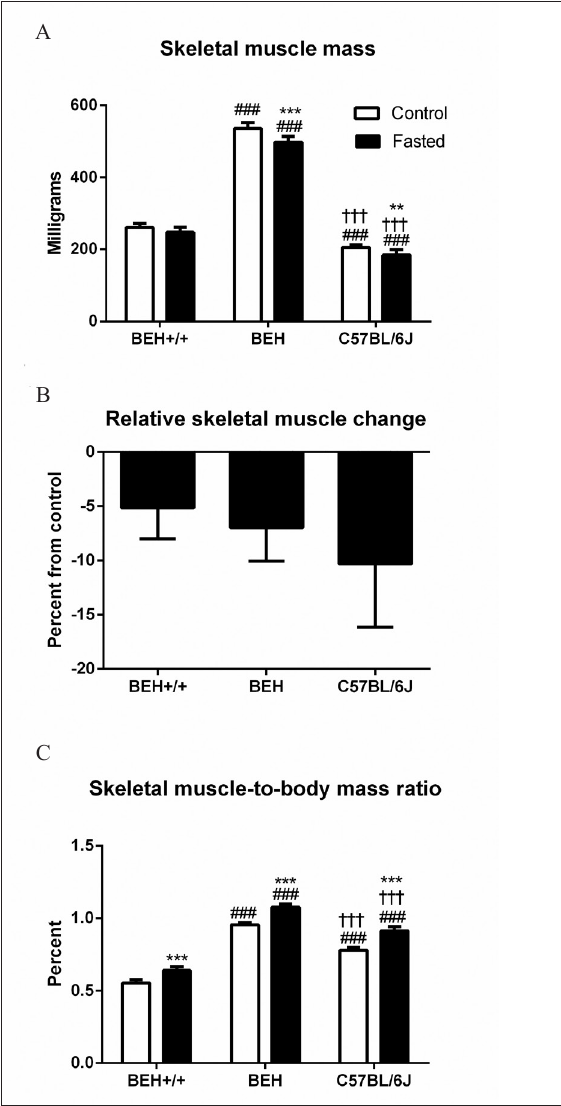
Figure 2. (A) Muscle mass, (B) percentage change in the muscle mass and (C) muscle to body mass ratio in control and fasted BEH+/+, BEH and C57BL/6J mice Notes. The muscle mass was calculated as the summed weight of gastrocnemius, plantaris, soleus, tibialis anterior and extensor